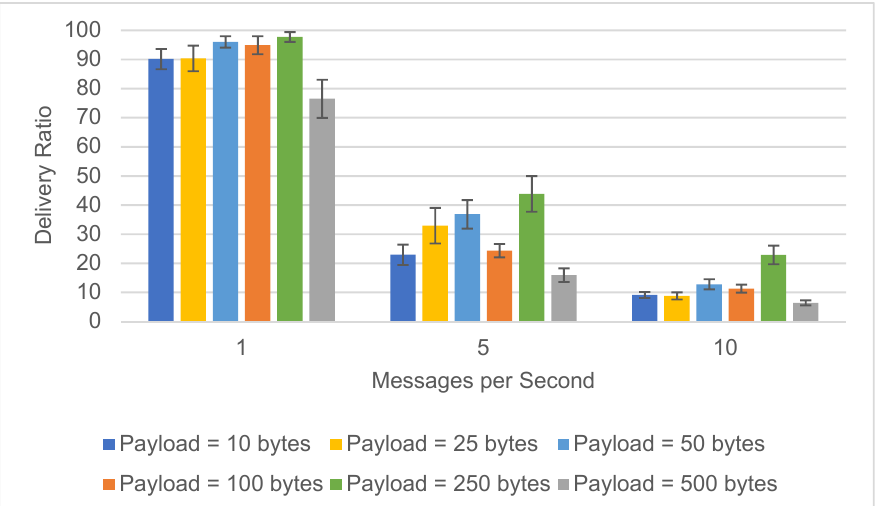
Figure 15. Delivery ratio (%) of messages (4 sensors and 1 destination).